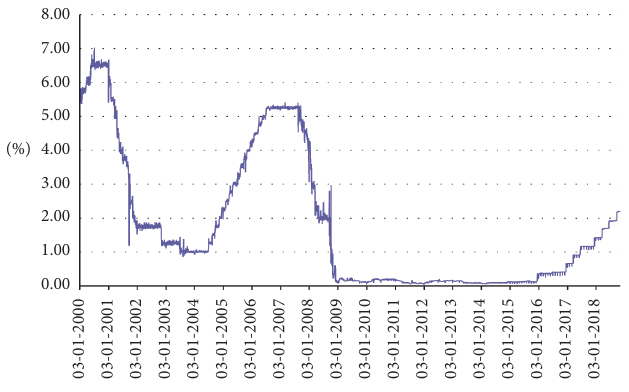
Figure 8: US federal fund effective